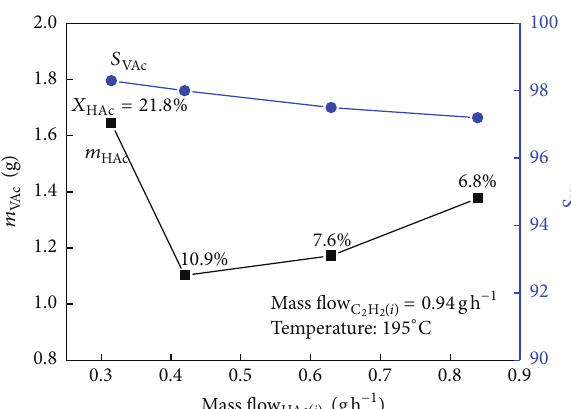
Figure 7: Effect of WHSV.